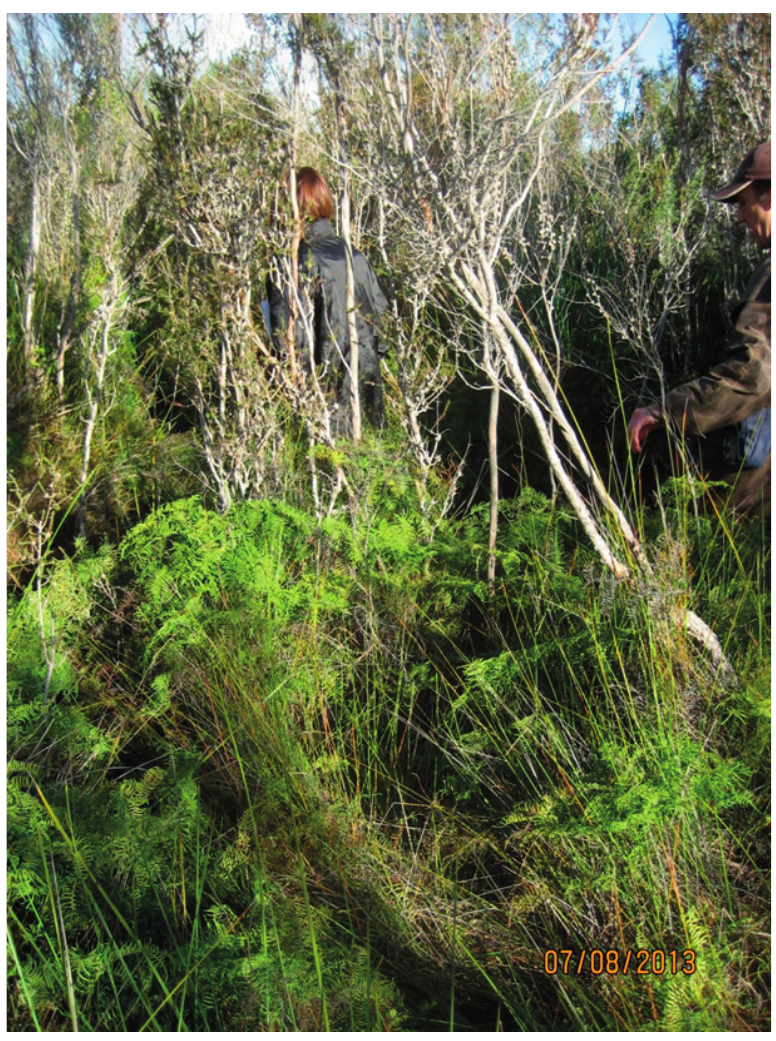
Figure 8. Swamp vegetation near Mt Compass, Fleurieu Peninsula. The bright green plant is the fern, Gleichenia (Photo: A. Malcolm